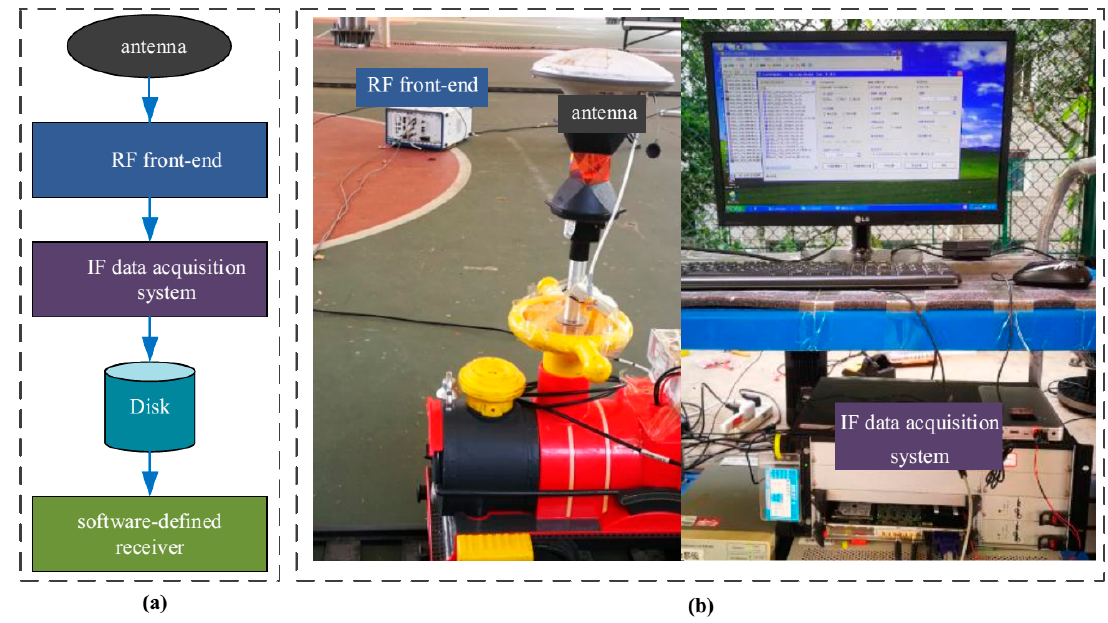
Figure 11. The architecture of the data collection system and hardware setup for the software receiver.